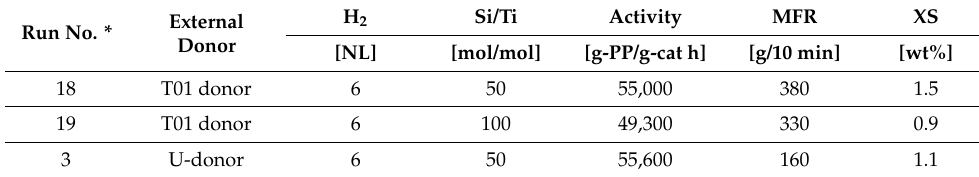
Table 4. Propylene polymerization results by T01 donor as external donor.